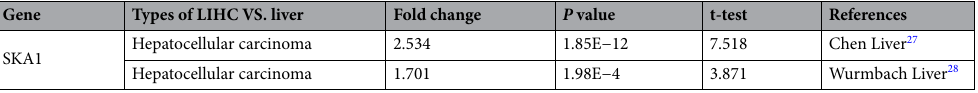
Table 1. Transcription expression of SKAs family members between LIHC and normal liver tissues (Oncomine).